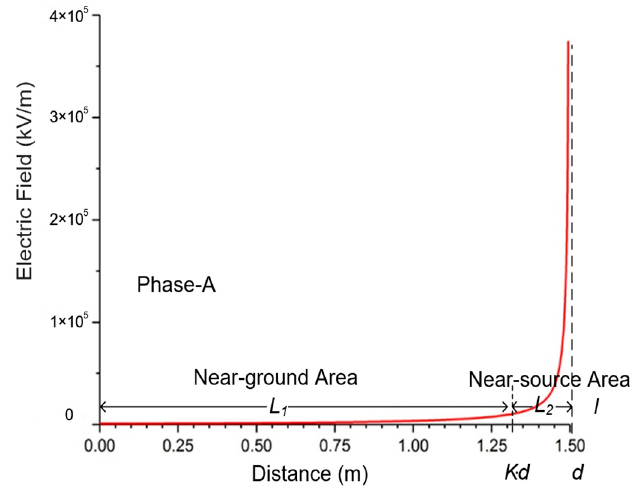
Figure 7. Simulation integral interval partition result.